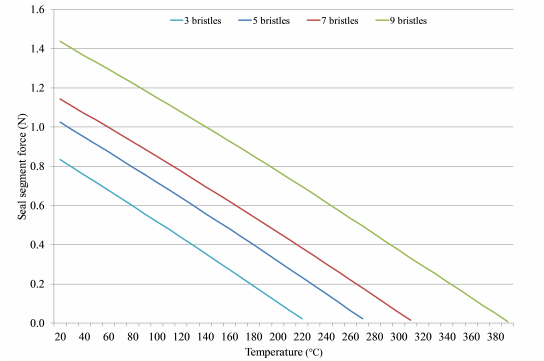
Figure 8: Seal segment force as a function of temperature for vari- ous bimetal/bristles ratio